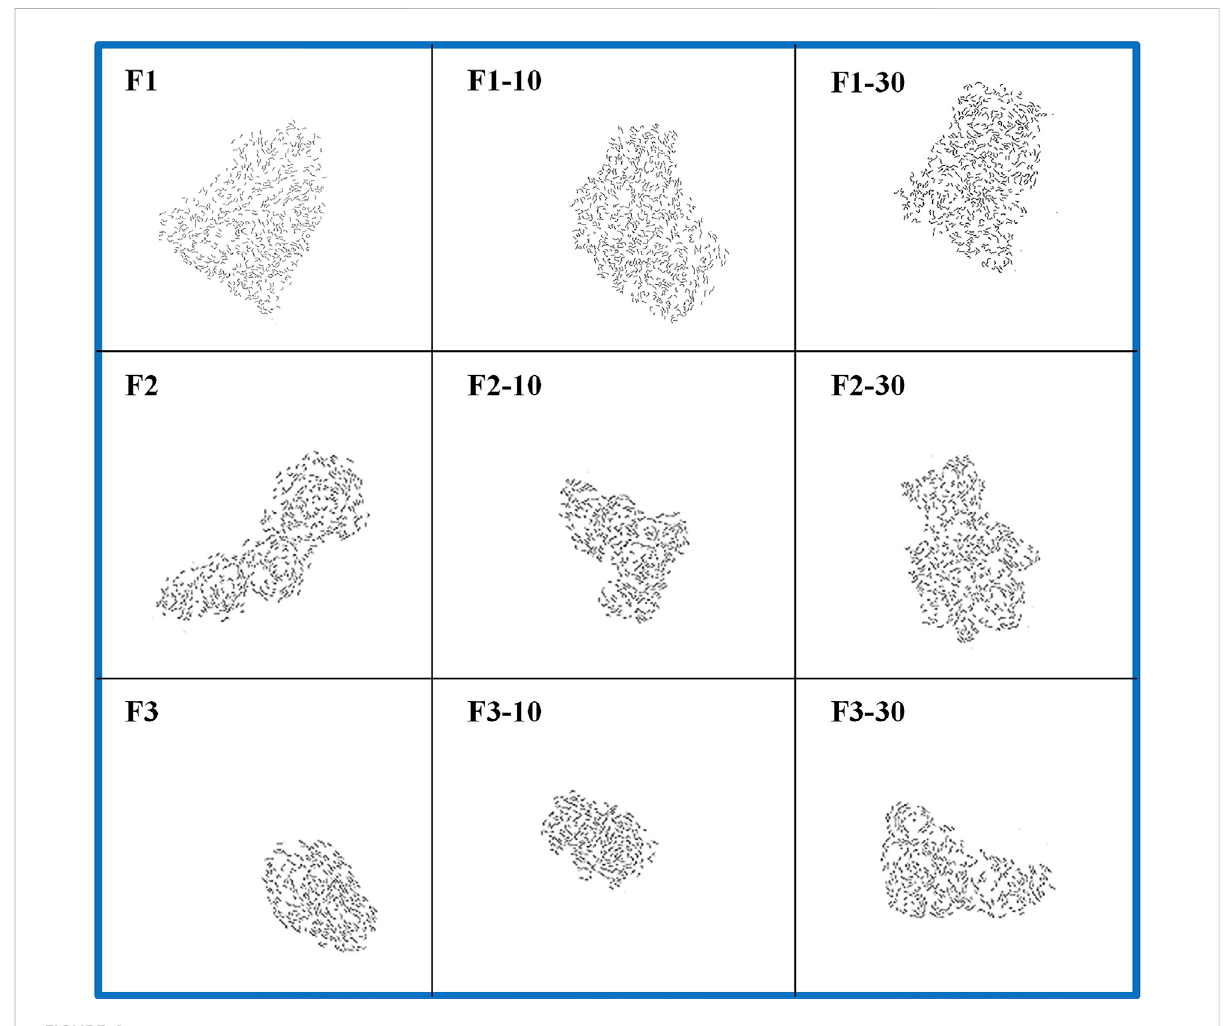
FIGURE 4 Skeletonized output images of the typical HRTEM images.